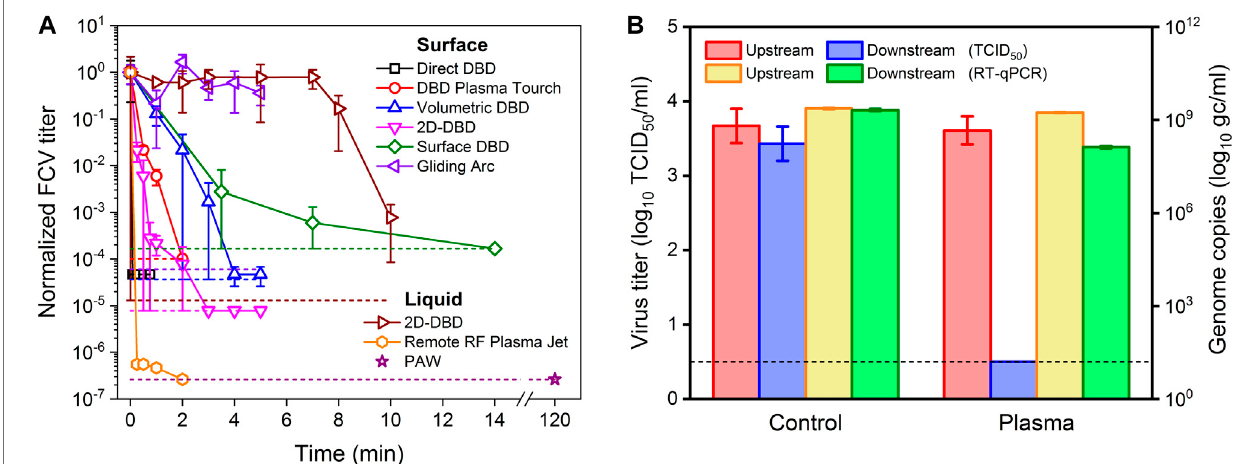
FIGURE7|(A) Inactivationcurves for FCVtreated on surfaces and in liquid solution by different plasma sourcesand con fi guration shown in Figure 6 . Thedata are taken from [67, 94, 95, 101, 162] and are normalized to the reference virus titer. The short dashed colored lines represent the detection limit for each of the corresponding plasma treatment. Note that the plasma power was 14.5 W for volumetric DBD, 2D-DBD and gliding arc, while a lower power was used for direct DBD (12 W), surface DBD (0.7 W) and RF plasma jet (2.5 W). The treatment of liquids is solution and volume dependent. In this case, the solution was distilled water and the volume was kept constant at 100 μ L. (B) Schematic representation of the inactivation of aerosolized PRRS virus by a volumetric DBD treatment in wind tunnel test conditions at sampling time of 5 min and discharge power of 39.6 W. The graph compares the amount of infectious virus before (control) and after (plasma)treatmentasobtained by theTCID 50 approach withameasureoftheremaininggenomeobtained with theRT-qPCRmethod.Theresults show areduction of 3.5 log 10 (remaininginfectivity isbelowdetection limit), while the genome remains, con fi rming that themajority of theinactivated virusisstillcollected downstream of the plasma treatment